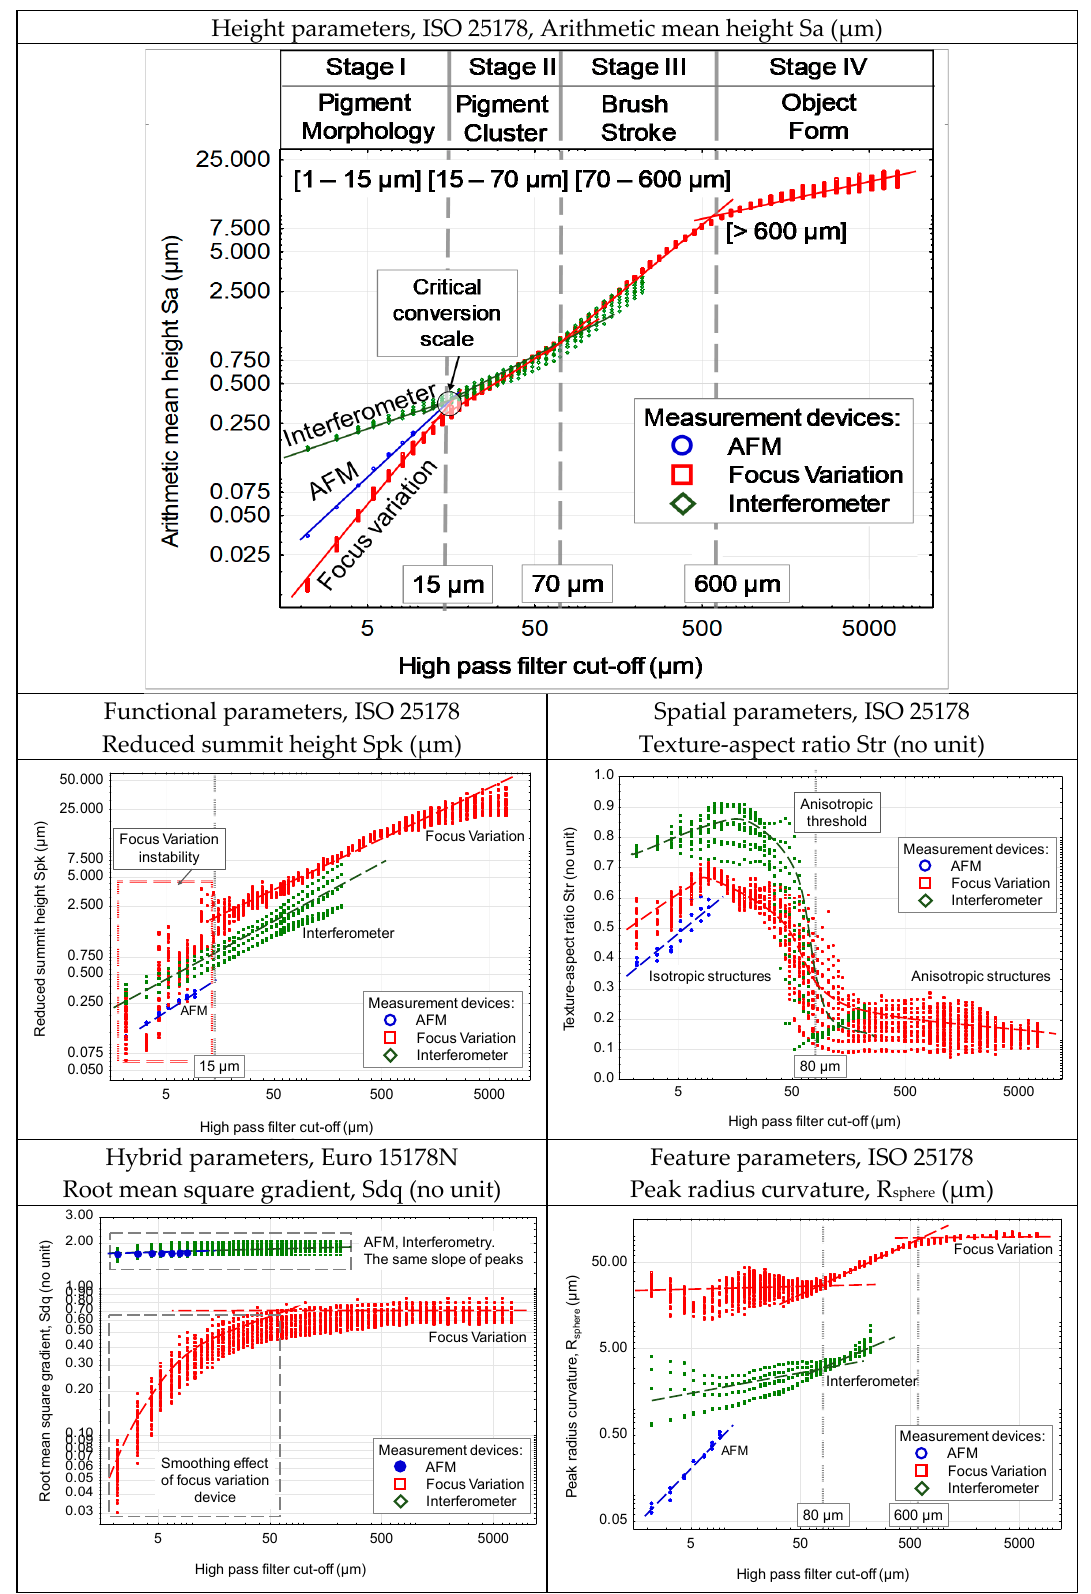
Figure 15. Multi-scale and multi-parameter characterization of the petal painting, from referenced to the Van Gogh “Sunflower” painting (see Figure A1). Sa, Spk, Str, Sdq, and radius curvature of asperities are plotted as a function of the scale (cut-off of Gaussian high pass filters).